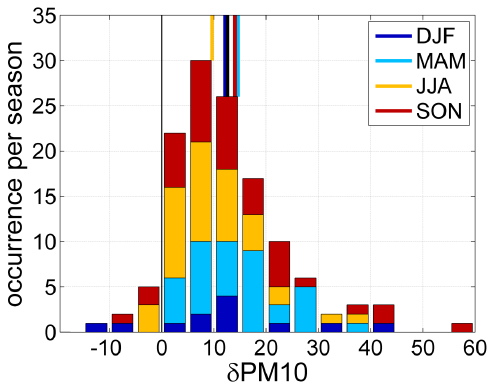
Fig. 3. Seasonal frequency distribution of all PM 10 changes associ- Figure 3. Seasonal frequency distribution of all PM 10 changes associated to Saharan 700 ated to Saharan advections ( δ PM) at the two Rome stations of MG advections (δPM) at the two Rome stations of MG and VA in the period 2001-2004. Colour 701 and VA in the period 2001–2004. Colour thick lines at the top of the bars at the top of the plots specify the seasonal average, the black bar representing the 702 plots specify the seasonal average, the black one representing the yearly average. 703 yearly